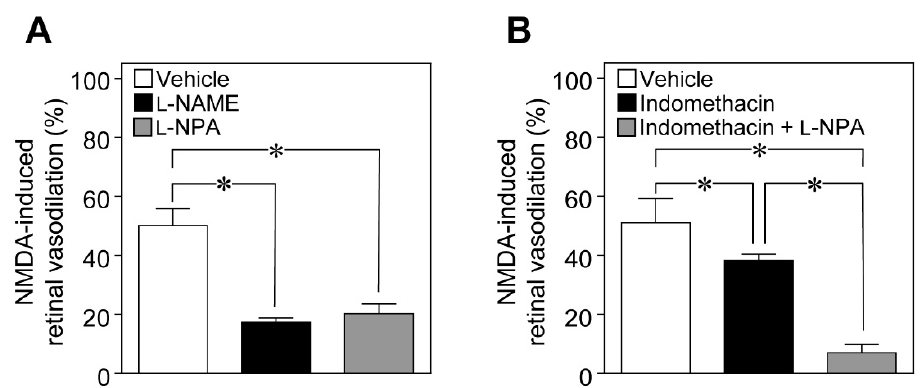
Figure 2. Involvement of nitric oxide (NO) and prostaglandins in the retinal vasodilator response induced by intravitreal injection of NMDA. ( A ) NMDA-induced changes in the retinal arteriolar diameter in the presence of N ω -nitro- L -arginine methyl ester ( L -NAME) (40 nmol), N ω -propyl- L -arginine ( L -NPA) (400 nmol), or the vehicle. ( B ) NMDA (6 nmol)-induced changes in the retinal arteriolar diameter in the presence of indomethacin (10 nmol), indomethacin + L -NPA (400 nmol), or the vehicle. Each column with a vertical bar represents the mean ± SE from four to six animals. * p < 0.05.